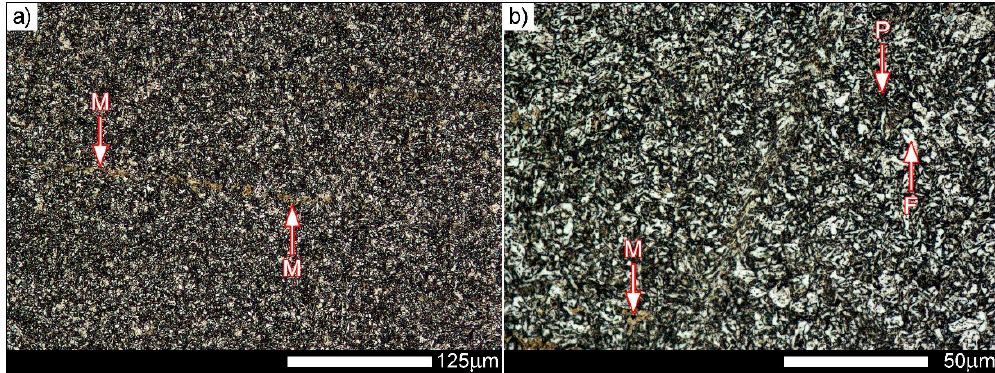
Figure 15. Microstructures of the Hardox 600 joint within the heat-affected zone—HAZ in Figure 3. F—ferrite, M—martensite, P—pearlite. Light microscopy (various magnifications), etched with 2% HNO 3 .